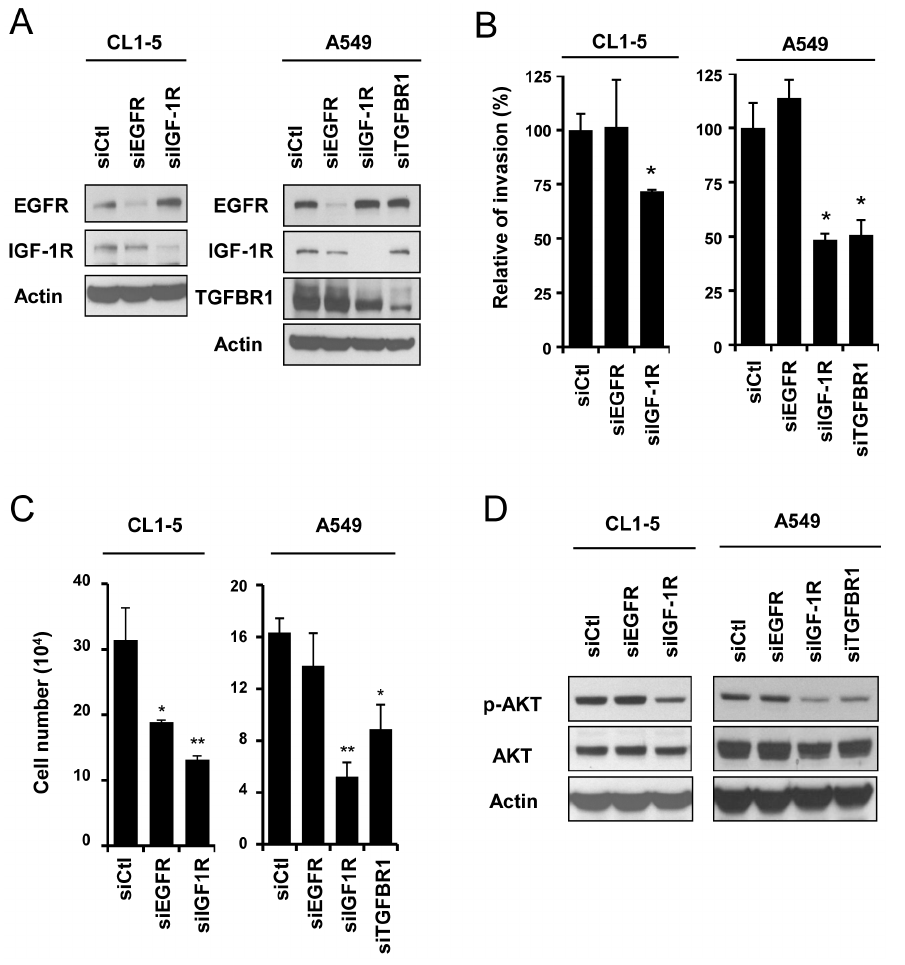
Figure 3. IGF-1R and TGFBR1 mediate cell invasion through AKT signaling in lung cancer cell lines. (A) Measurement of the protein levels of receptors CL1-5 or A549 cell transfected with siEGFR, siIGF-1R or siTGFBR1. (B) Measurement of the cell invasion ability of CL1-5 or A549 cells transfected with siEGFR, siIGF-1R or siTGFBR1 for 48 hours. The number of invasive cells was counted 20 hours after the transfected cells were seeded and was presented relative to invasion of cells transfected with siCtl. (C) Measurement of the cell proliferation ability of CL1-5 or A549 cells transfected with siEGFR, siIGF-1R or siTGFBR1 for 72 hours. (D) Representative immunoblots show protein levels of pAKT (Ser473), AKT and b -actin in these